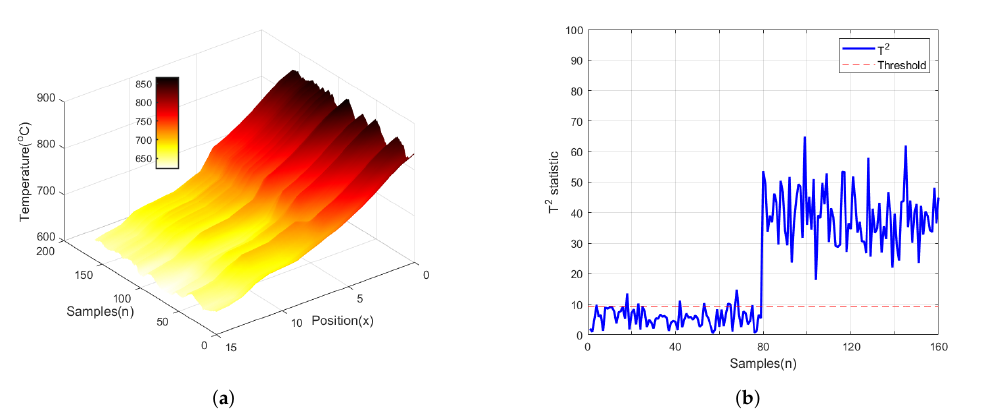
Figure 13. The temperature distribution ( a ) and monitoring result ( b ) of fault two.